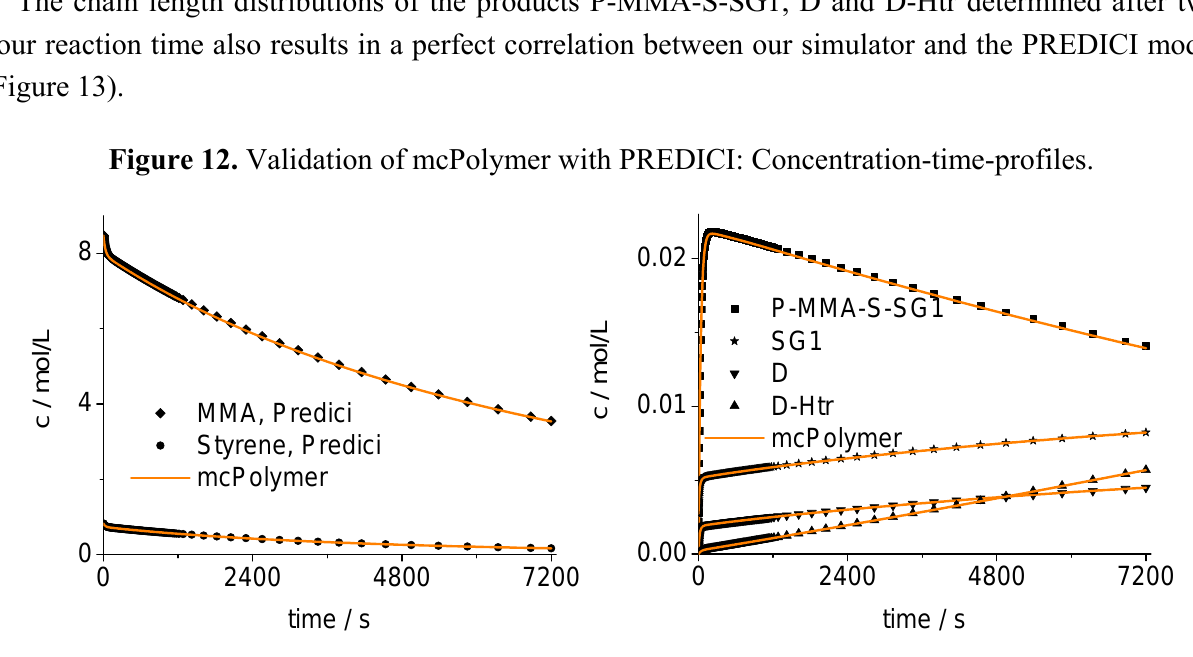
Figure 13. Validation of mcPolymer with PREDICI: Chain length